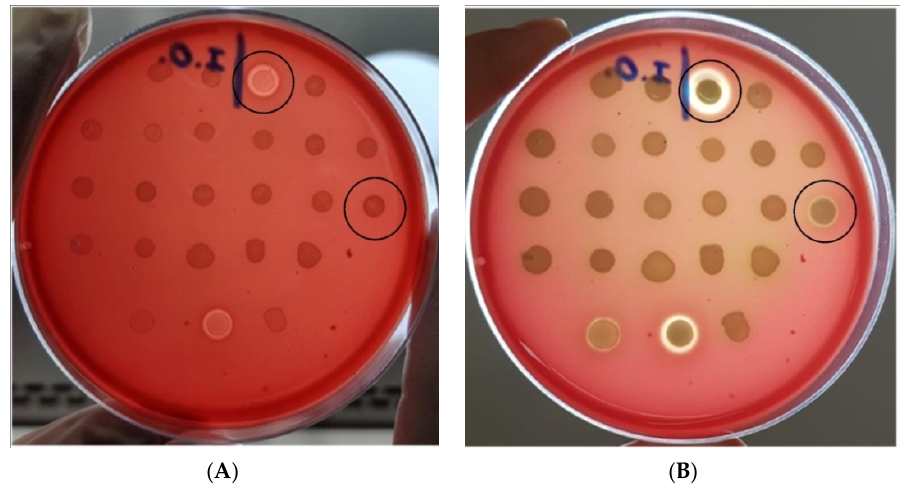
Figure 2. Blood agar plate inoculated with Escherichia coli strains isolated from eye infections ( A ) after 3 h of incubation; ( B ) after 24 h of incubation. Positive strains are circled in black. Controls at bottom row (from left to right): Shiga-toxin producing E. coli (STEC) strain EDL933 (enterohemolysin producer), UPEC strain CFT073 (alpha-hemolysin producer), and Klebsiella spp. K33 (non-hemolytic strain). The ocular E. coli strain C ‐ 3a was not included in this test.